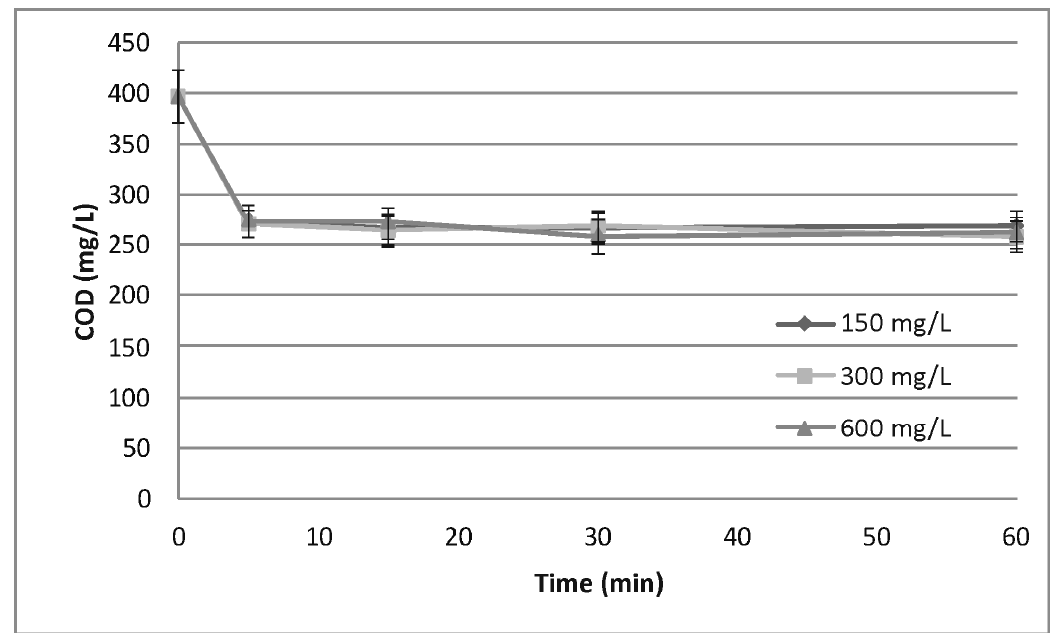
Figure 1. COD (chemical oxygen demand) removal in Fenton process: Fe 2+ dose 75 (mg/L), sedimented wastewater.